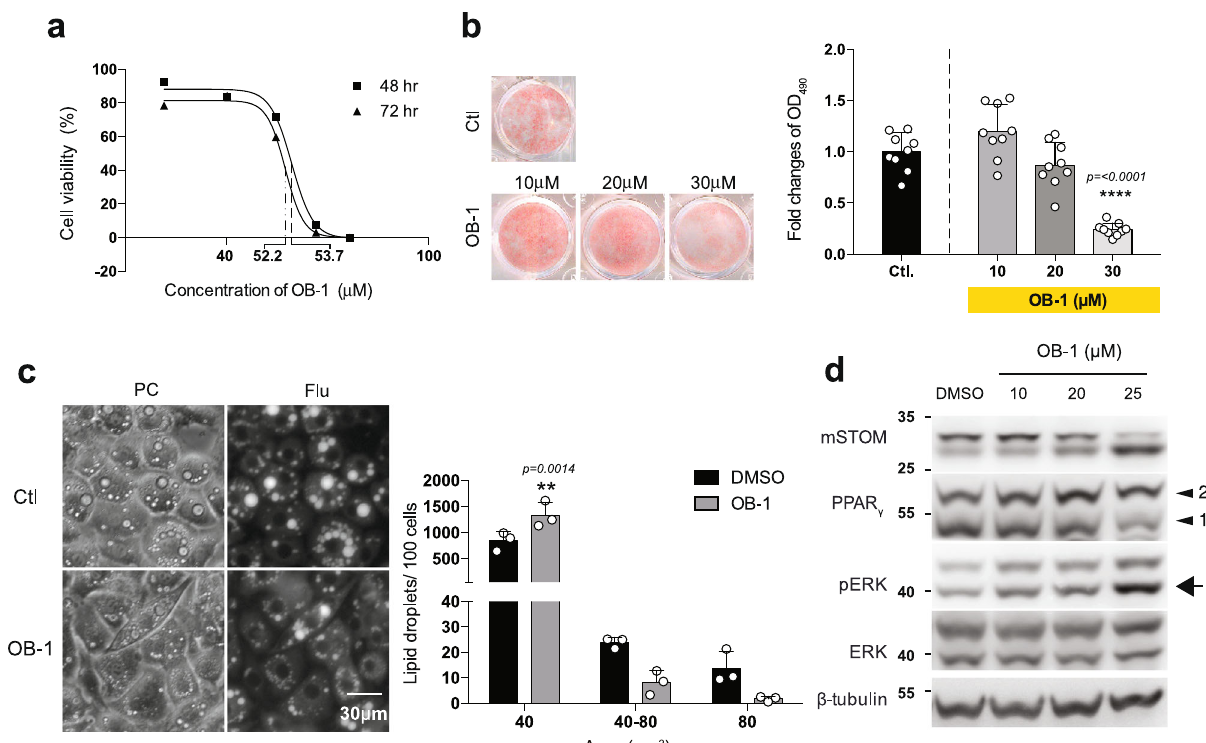
Fig. 8 Stomatin inhibitor OB-1 inhibited adipogenesis and hindered lipid droplet growth. a Cell viability after OB-1 treatments for 48 h or 72 h were tested by MTT assays. LC 50 for OB-1 were tested from three independent experiments. b Cultured plates of adipocyte-like cells were treated with or without OB-1 at concentrations indicated, stained with Oil Red O and subjected to OD 490 quanti fi cations. Note OB-1 inhibited adipogenesis in a dose- dependent manner, compared to the control DMSO treatment. Each OB-1 treatment data was normalized to the corresponding DMSO vehicle control; fold changes are shown. Mean ± s.d. for three independent experiments ( n = 3 for each experiment). **** P < 0.0001 by one-way ANOVA. c Adipocyte-like 3T3- L1 cells after 7-day induction were treated with 25 µ M OB-1 or control vehicle; LDs of these cells were labeled by AdipoRed. The numbers and sizes of LDs were determined. Histogram analyses showed more small LDs (<40 µ m 2 ) and less large LDs (>80 µ m 2 ) after OB-1 treatments, compared to the control. Mean± s.d. for three independent experiments. ** P < 0.01 by two-way ANOVA. Bar = 30 µ m. d Treating adipocyte-like cells with stomatin inhibitor OB-1 also resulted in activation of ERK pathway, evidenced by increased pERK (arrow). Source data are provided as a Source data fi